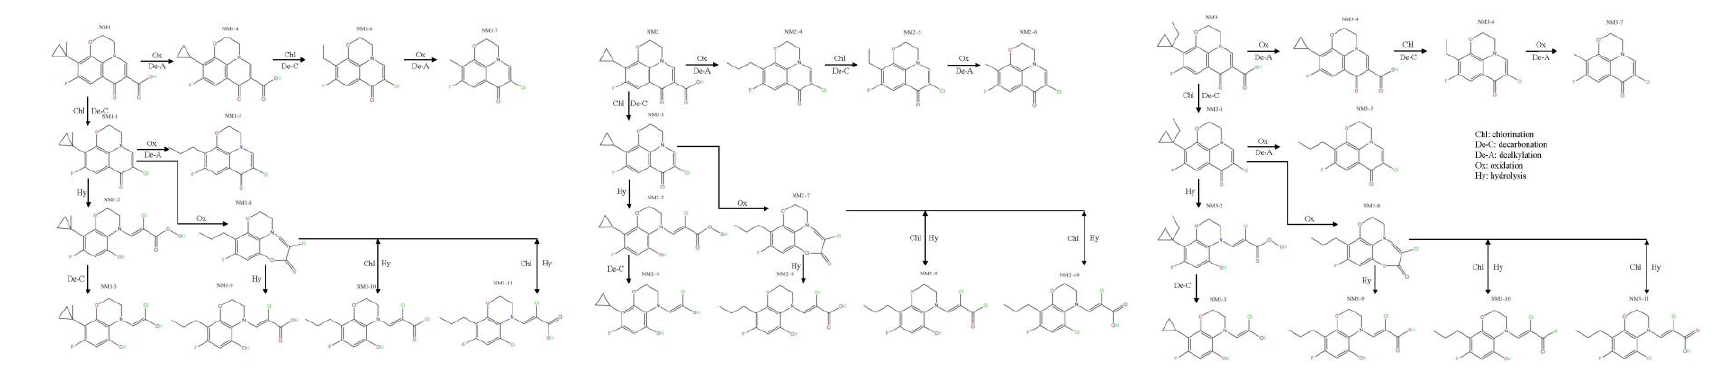
Figure 9. Conversion path of disinfection by-products of PAZ derivatives.